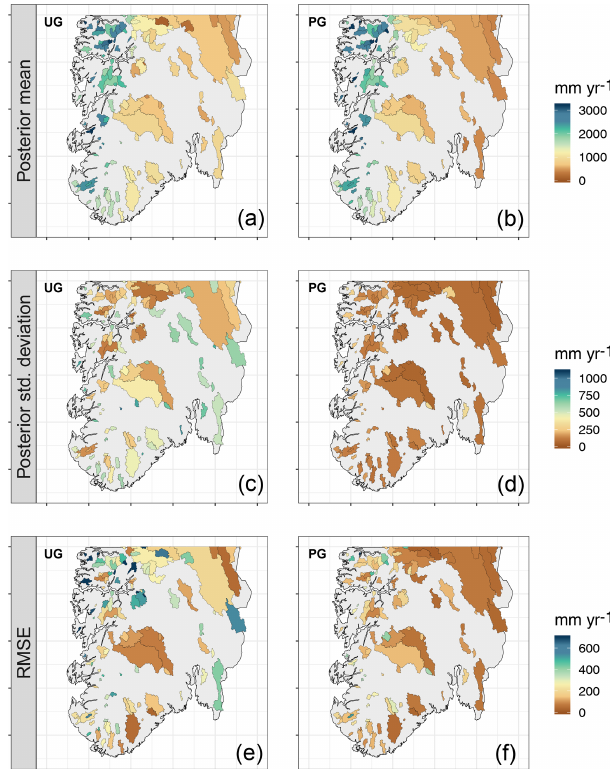
Figure 12. Average posterior mean Q j ( A ) (a, b) , average posterior standard deviation (c, d) and RMSE (e, f) for j = 1 ,..., 10 for pre- dictions of missing annual observations for the areal model for the ungauged case (UG, a, c, e ) and the partially gauged case (PG, b, d, f ).